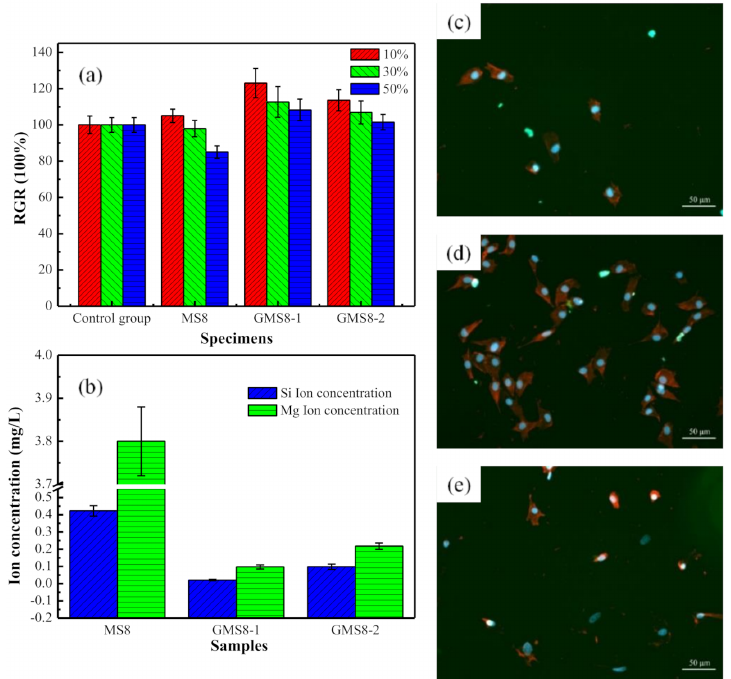
Figure 6. Cell viability of MC3T3-E1 cells co-cultured with extracts for 3d ( a ); ion concentrations of PBS ( b ) with the specimens soaked for 7 days; immunofluorescence figures of ME3T3-E1 cells cultivated with extracts of MS8 ( c ), GMS8-1 ( d ) and GMS8-2 ( e ) for